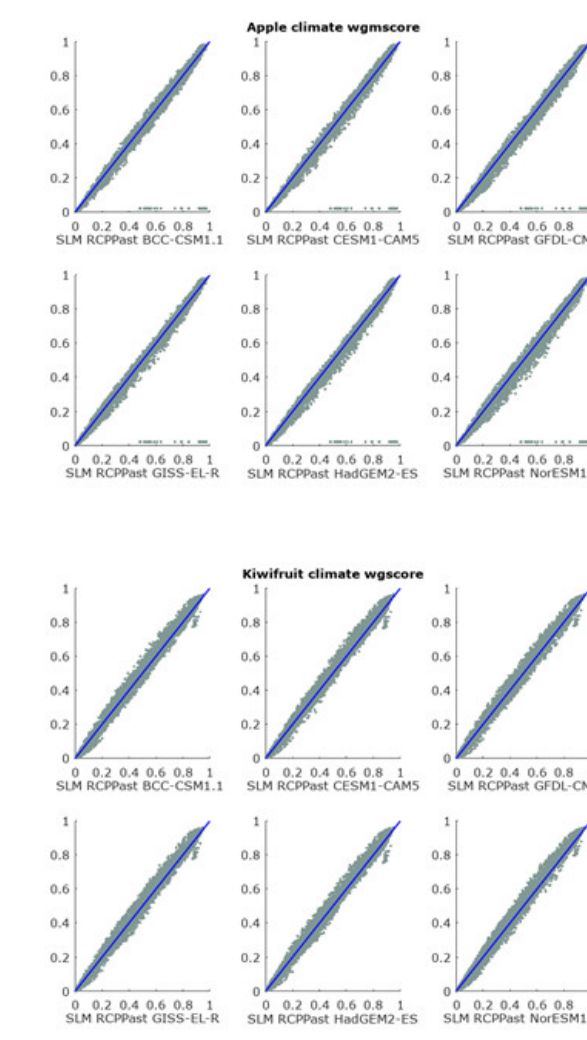
Figure 3. One-to-one graphs comparing performance of the original Representative Concentration Pathway (RCP) Past datasets ( left hand panels) and the adjusted “SLM RCP” Past datasets ( right hand panels) in terms of baseline agreement with Virtual Climate station Network (VCSN) based on overall climate suitability scores for apple ( upper panels) and kiwifruit ( lower panels) in New Zealand. Each grey dot is the plot of an RCP-based score (ordinate) vs VCSN-based score (abscissa) for a location. The blue line is the line of equality. Text below each graph refers to the global climate model and does not label the axis.